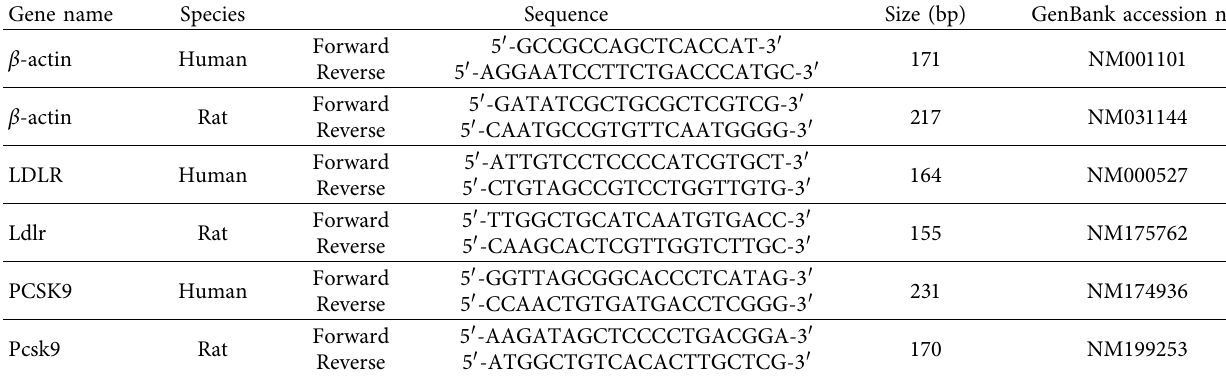
Table 1: Primer sequences for real-time quantitative RT-PCR.